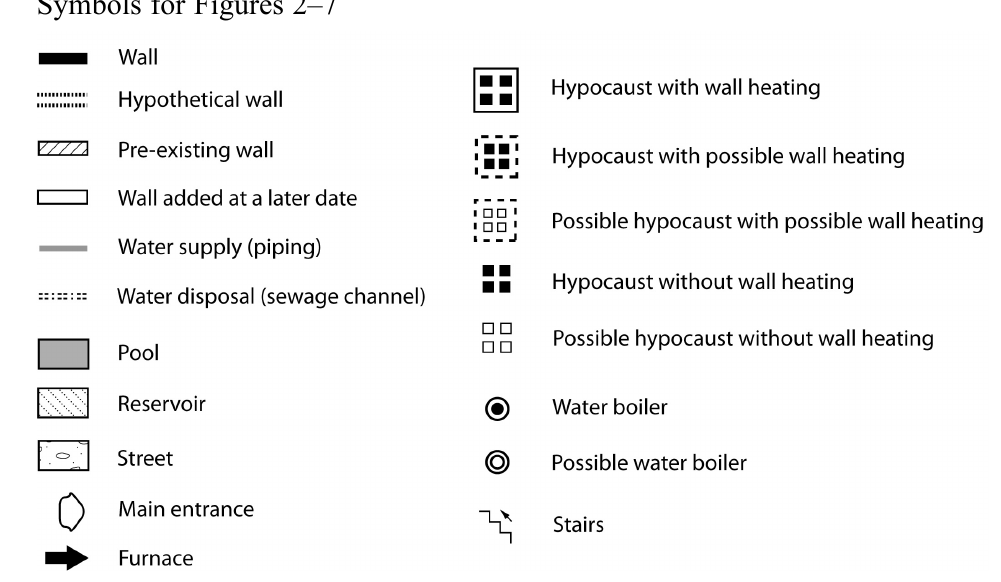
Symbols for Figures